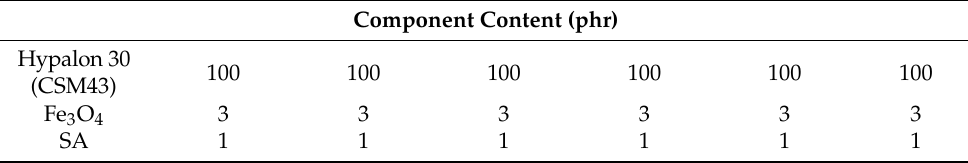
Table 5. The formulations of the composites used in the second series of